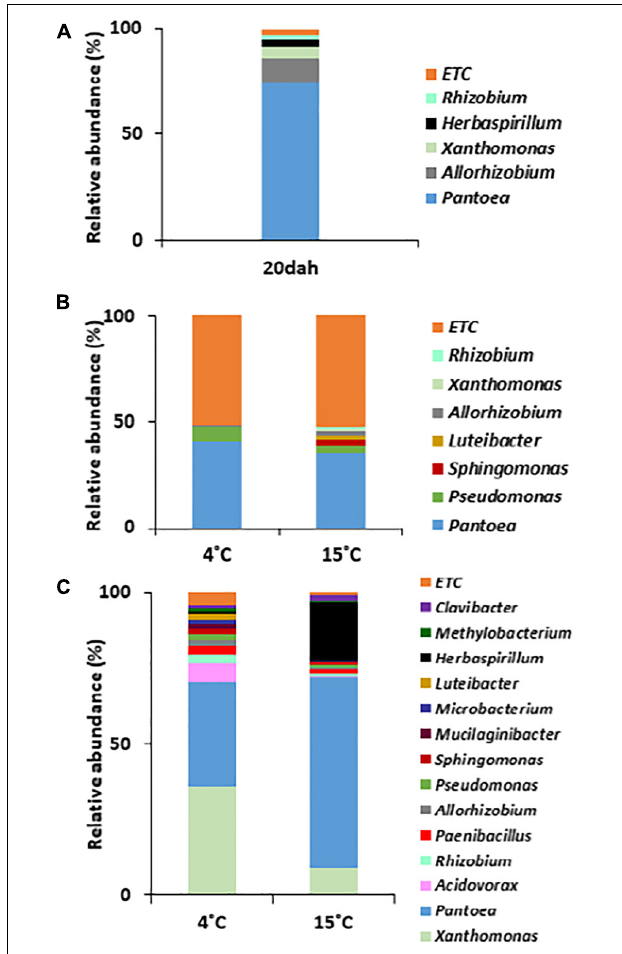
FIGURE 4 | Comparison of bacterial composition in rice seeds at the genus level. The bacterial species with relative abundance > 1% were compared between rice seeds of Shindongjin that are sampled (A) at 20 days after heading (dah), (B) 4 months after storage (mas) at 4 and 15 ◦ C, and (C) 10 days after germinated seeds stored for 6 months at 4 and 15 ◦